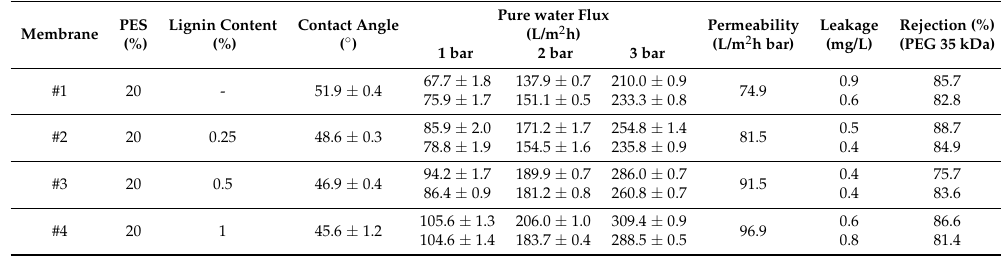
Table 2. Polymer solution condition, contact angle ( ± 95% confidence Interval), pure water flux at different pressures, leakage (TOC results of pure water after 10 min), and PEG 35 kDa rejection of fabricated